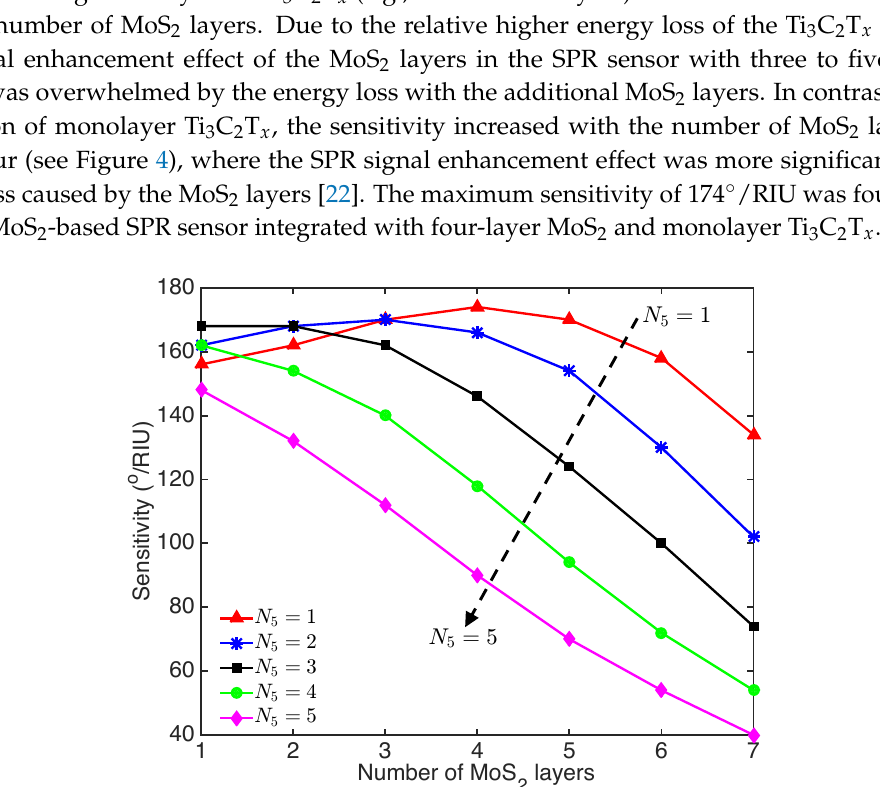
Figure 4. Sensitivity as a function of the number of MoS 2 layers for Ti 3 C 2 T x -MoS 2 -based SPR sensor with different layers of Ti 3 C 2 T x